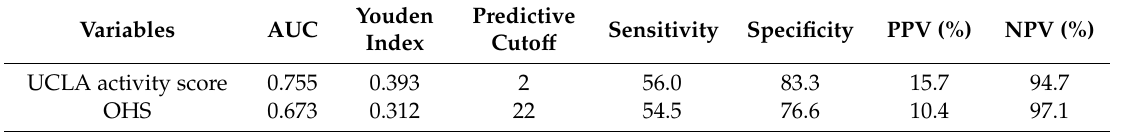
Table 8. The diagnostic value of the UCLA activity score and